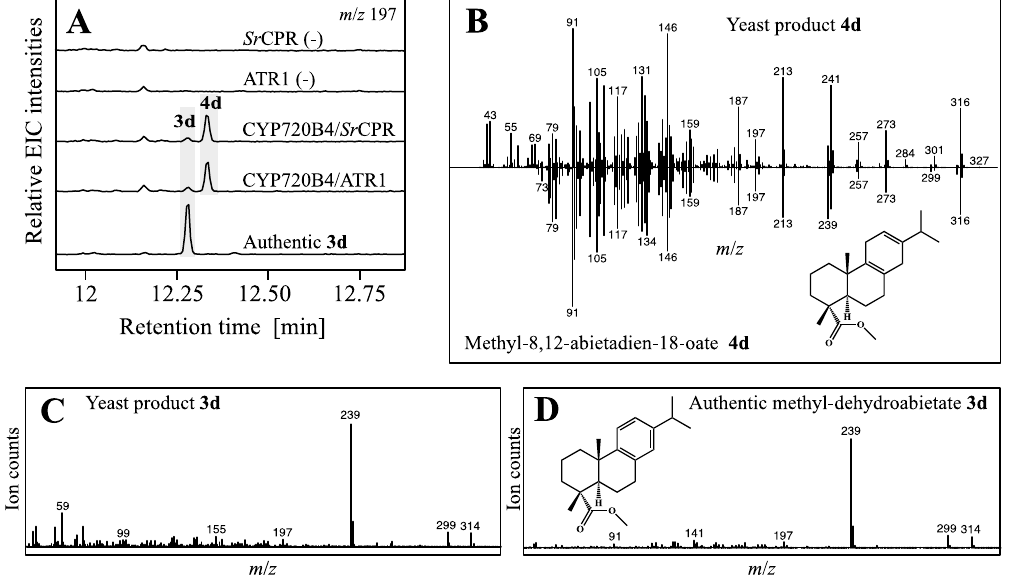
Figure 4. Production of the target and putative triptolide intermediate 3 and its analog 4 in yeast. ( A ) Extracted ion chromatograms (EIC) with m / z 197 of control strains expressing CPRs and diTPS, and strains additionally expressing Ps CYP720B4; ( B ) Comparison of MS spectra between yeast product 4d (above) and reported spectrum of methyl-8,12-abietadien-18-oate (below) reported by [31]; ( C ) MS spectrum of yeast product 3d ; ( D ) MS spectrum of authentic methyl-dehydroabietate ( 3d ) matching yeast product 3d .